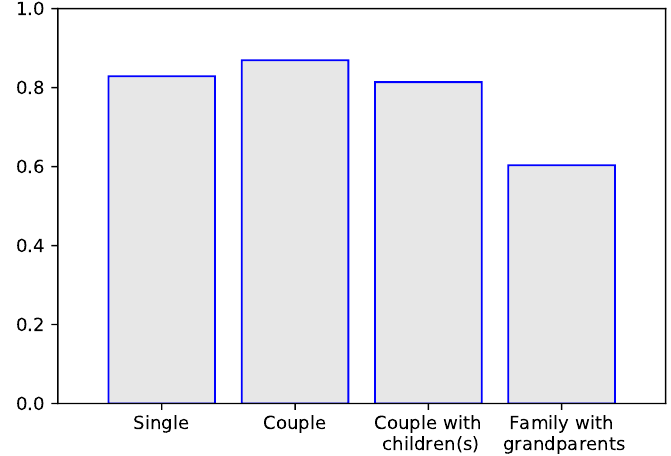
Figure 5. The model